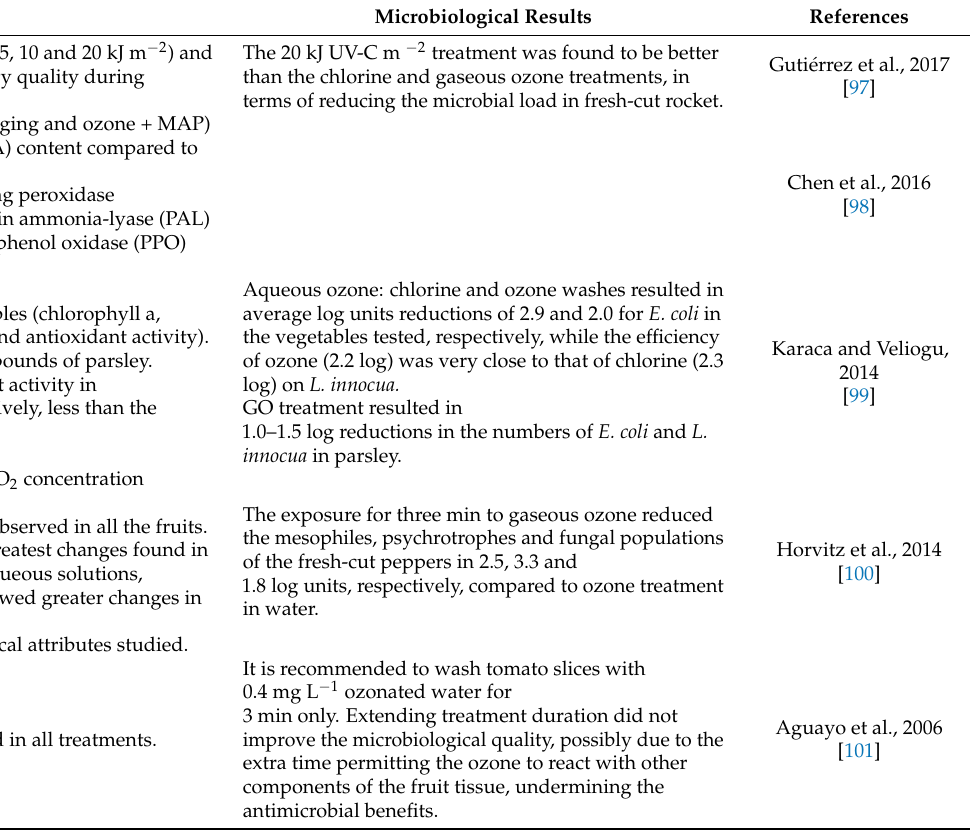
Table 3. Effect on the quality parameters and microbiological control of fresh-cut vegetables treated with gaseous